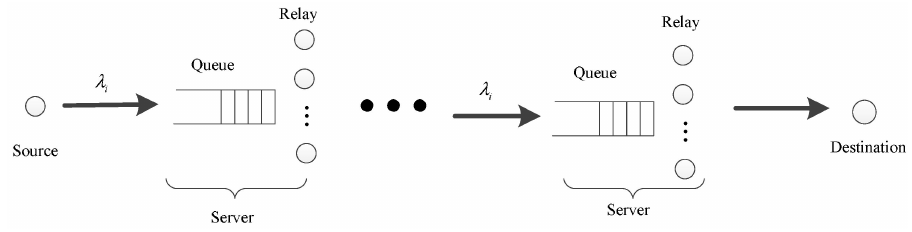
Figure 4. Queue in network for δ ≤